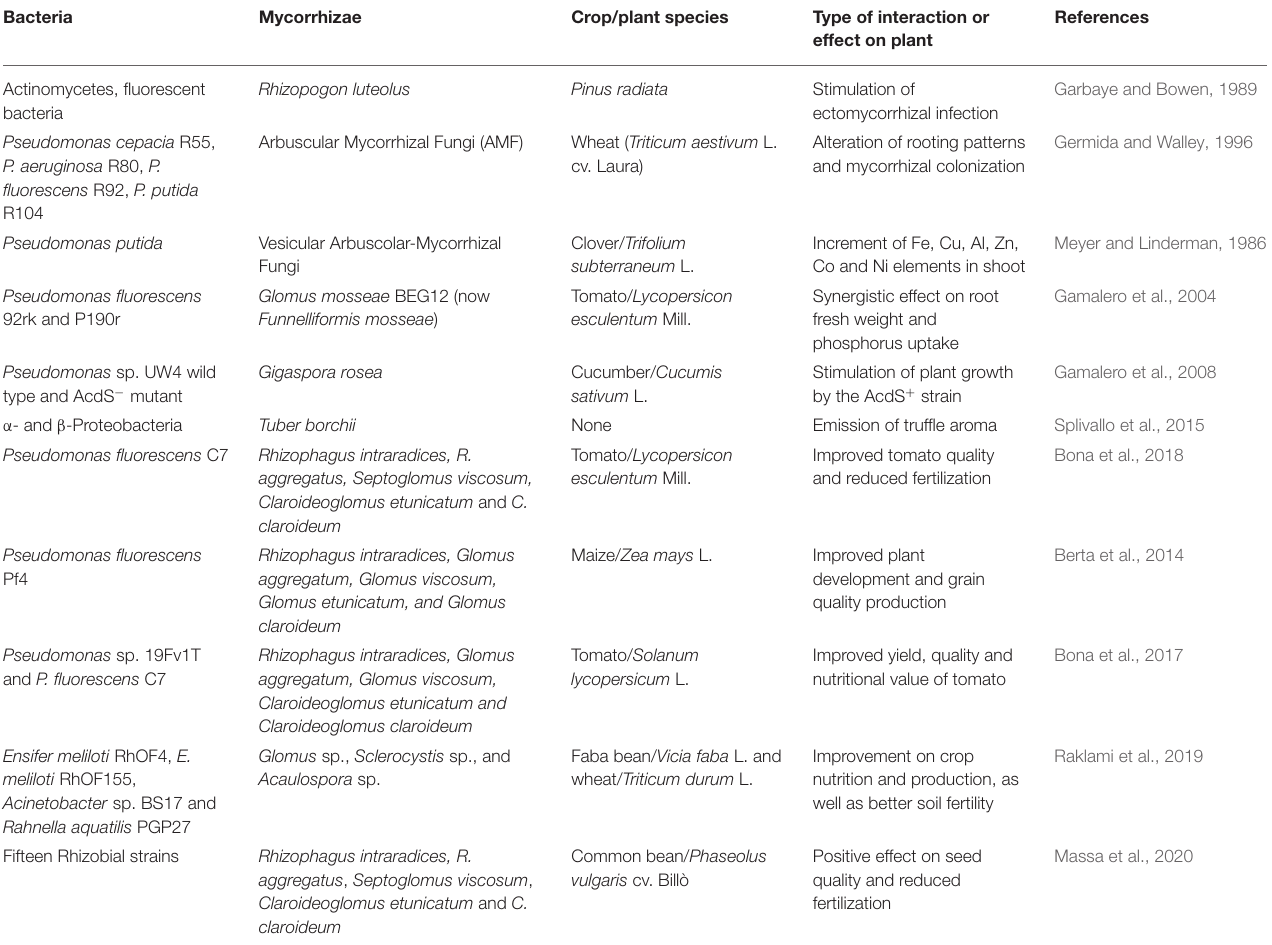
TABLE 1 | Examples of pioneering and recent works reporting interactions between mycorrhizae and